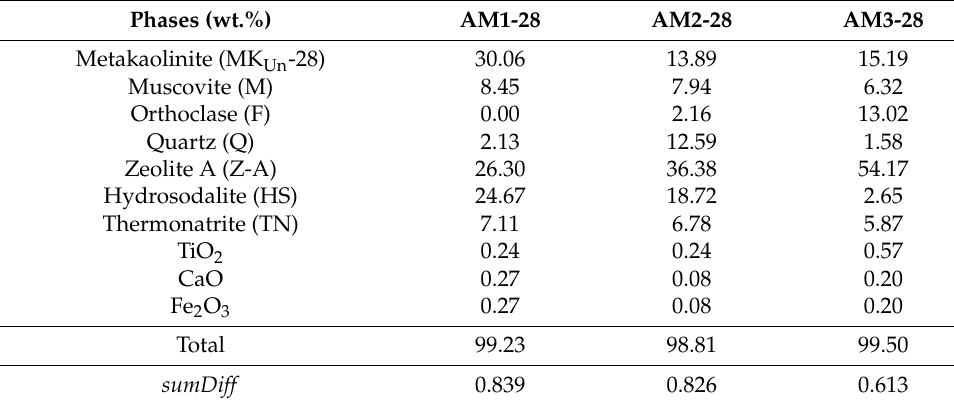
Table 5. CQMA of alkali-activated AM-28 samples.